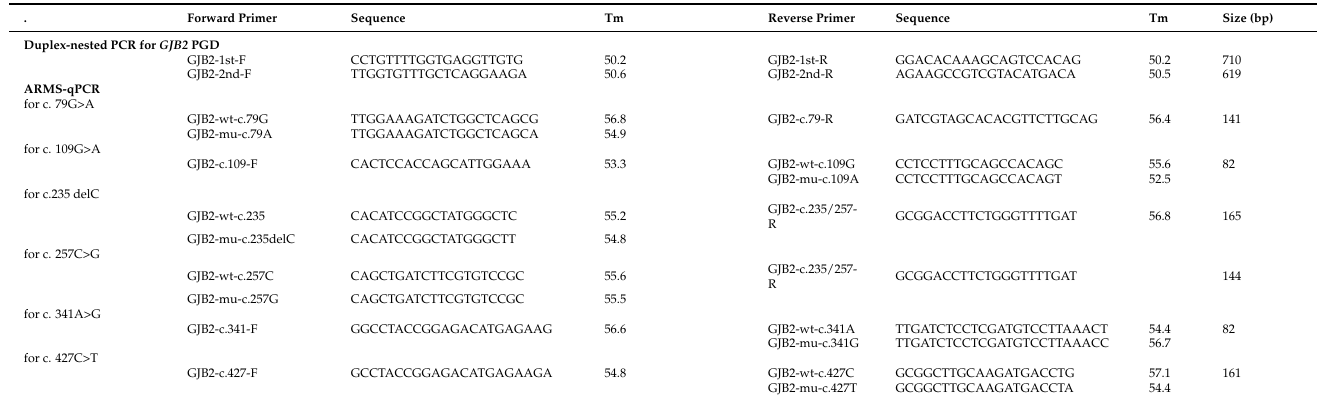
Table A1. ARMS-qPCR primers